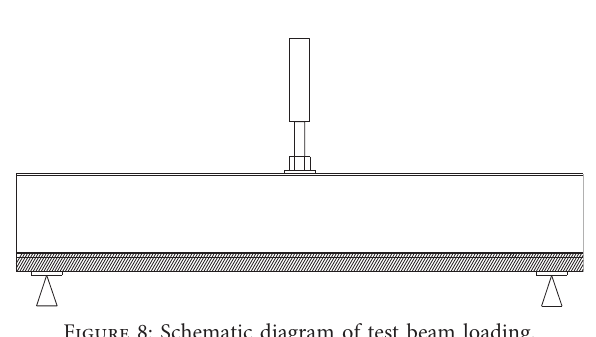
Figure 8: Schematic diagram of test beam